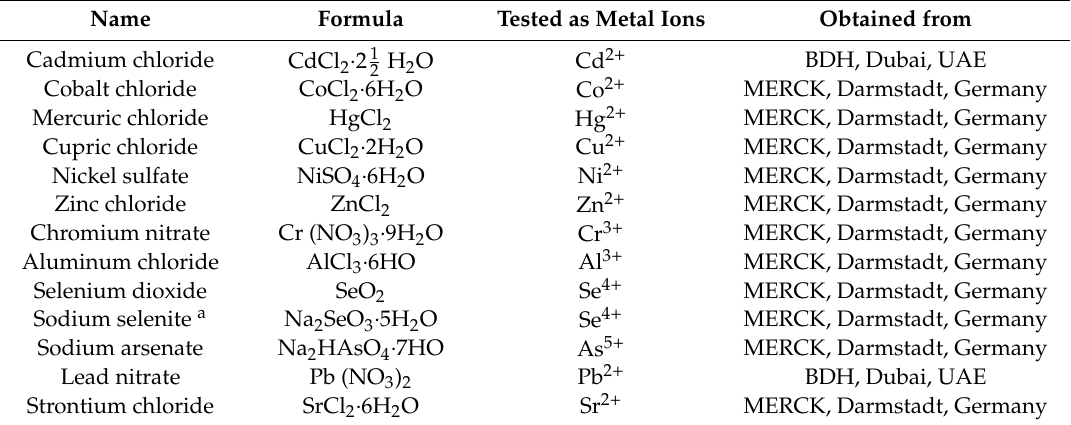
Table 1. Chemical compounds